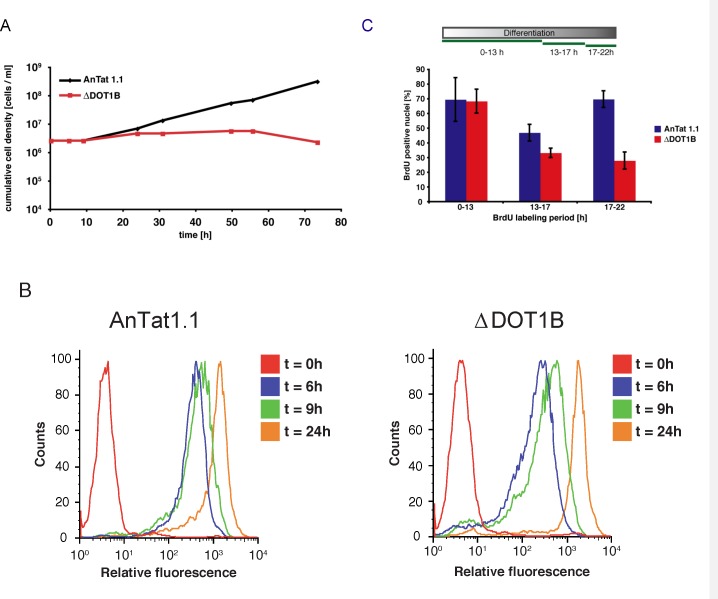
Analysis of early differentiation events from short stumpy to procyclic form.(A) Cumulative growth curve after induction of in vitro differentiation. After one population doubling ∆DOT1B trypanosomes undergo growth arrest and die after several days. (B) Detection of procyclin on the surface of differentiating trypanosomes by flow cytometry. Increasing relative fluorescence correlates with the amount of surface exposed procyclin during the course of differentiation. Procyclin expression is indistinguishable in wild-type and ∆DOT1B populations. (C) BrdU incorporation of differentiating trypanosomes. When differentiating cells re-enter the cell cycle both cell lines incorporate BrdU into freshly replicated DNA. Addition of BrdU for different time periods during differentiation demonstrates that the number of actively replicating cells decreases in DOT1B-deficient cells. The statistical analysis with an unpaired t-test shows significance between the data sets marked with bars and asterisks (* p-value <0.05, ** p-value <0.01).